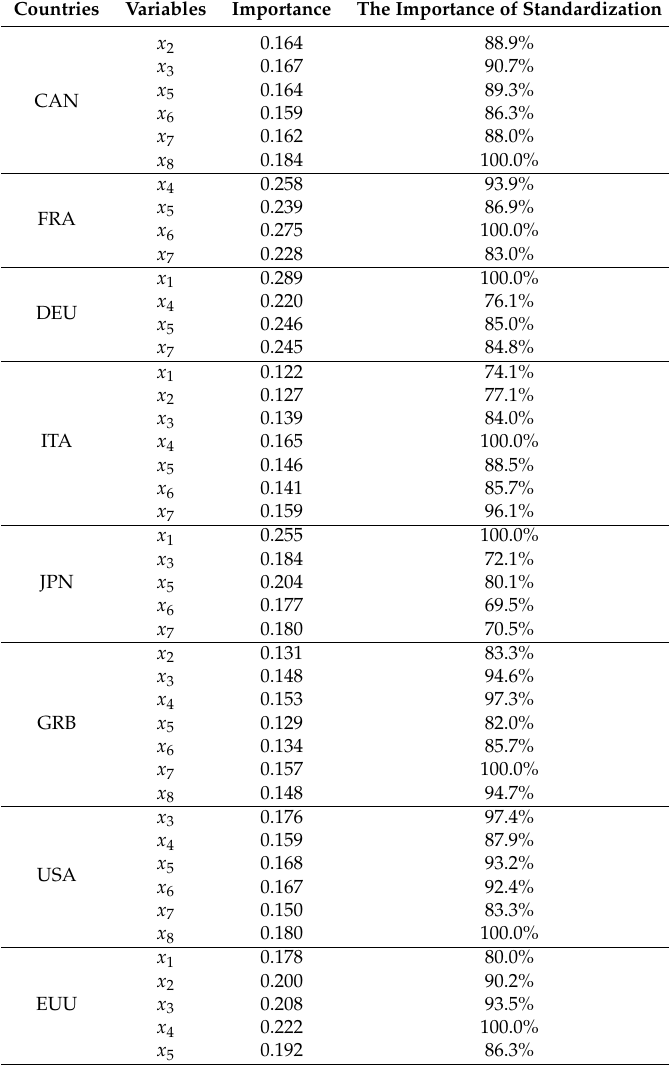
Table 4. The importance of input